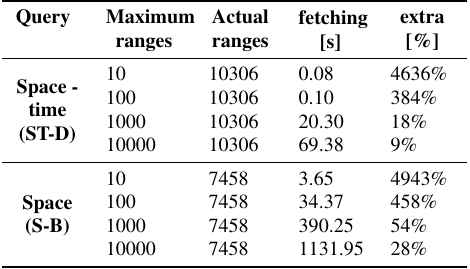
Table 6: Using different magnitudes of maximum ranges in the WHERE statement of the non-integrated